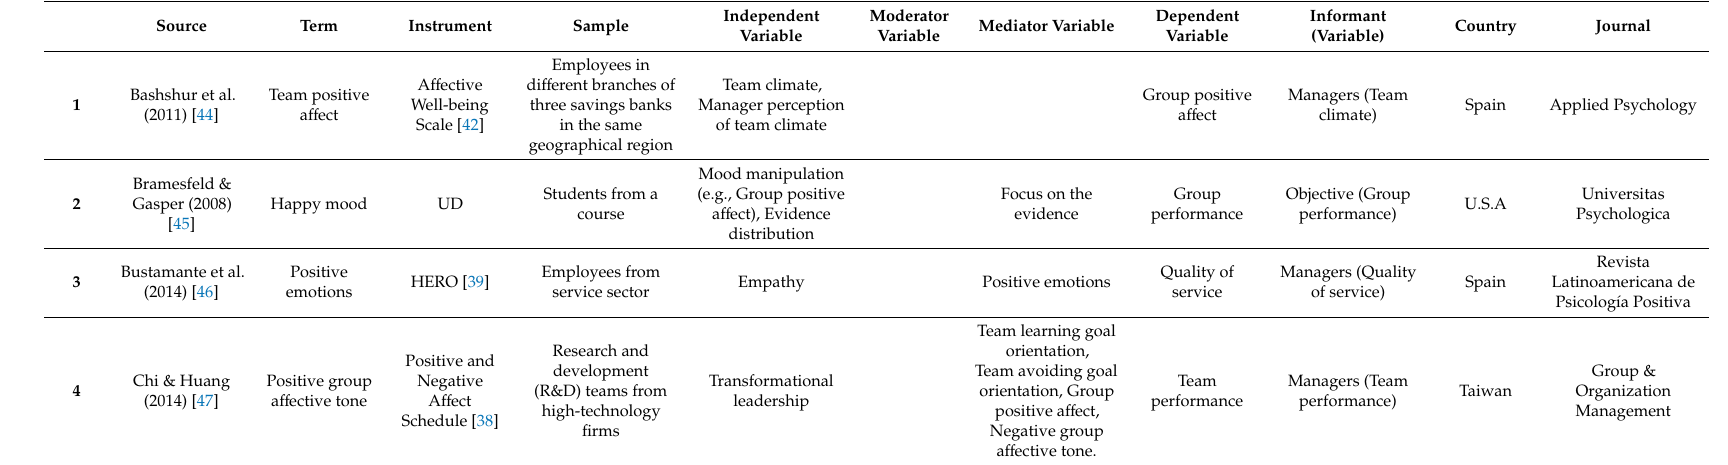
Table 2. Summary of studies included in the